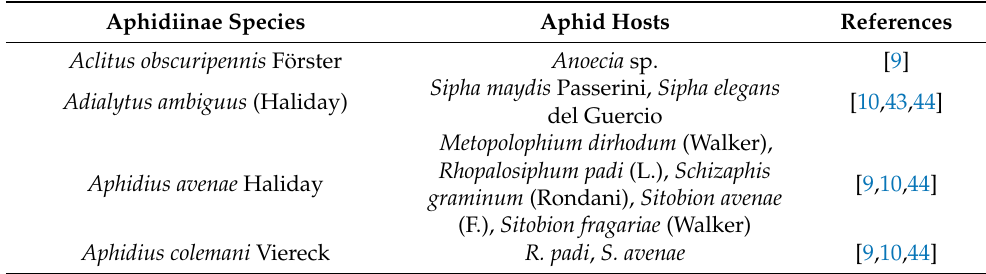
Table 1. Cereal aphid parasitoids (Hymenoptera: Braconidae: Aphidiinae) in Europe. Aphidiinae